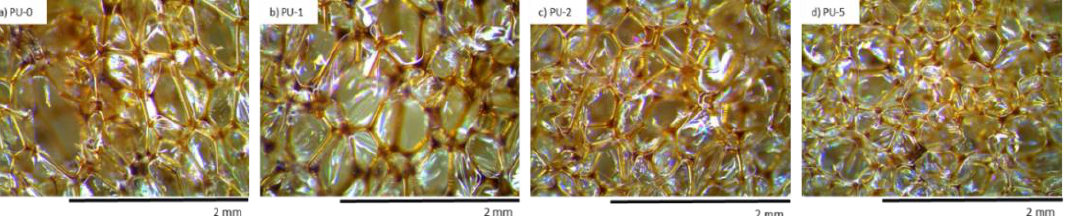
Figure 13. Morphology of PUR composite foams after 7 days of UV aging observed at a magnification of ×50. Adapted from Ref. [9].